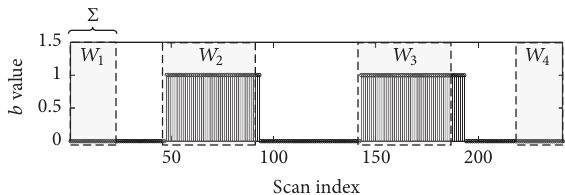
Figure 17: Illustration of performing the subframe-scan operation on a 3200-sample frame; that is, 𝑀 = 800 , with 𝛿 = 10 , 𝑢 = 30 , 𝑙 = 80 , and “1” being embedded into the second subframe of the frame.